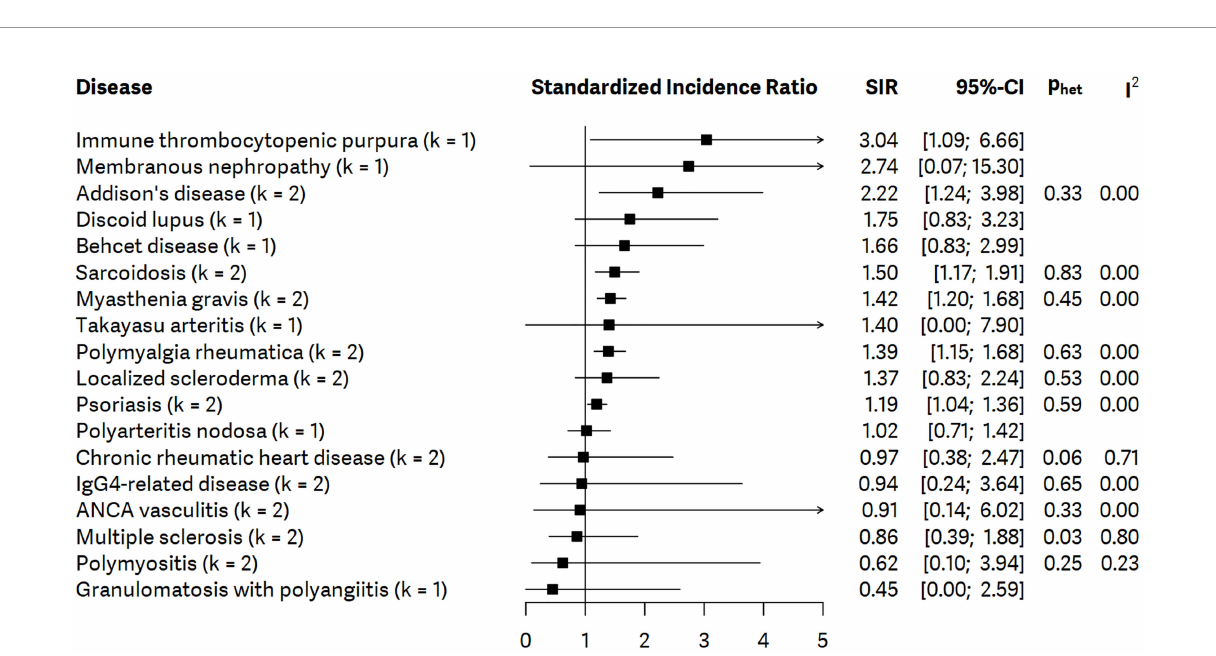
FIGURE 2 | Summarizing forest plot with pooled standardized incidence ratios (SIRs), representing the incidence of gastric cancer in all patients with autoimmune disorders included in meta-analysis; number of studies – k .